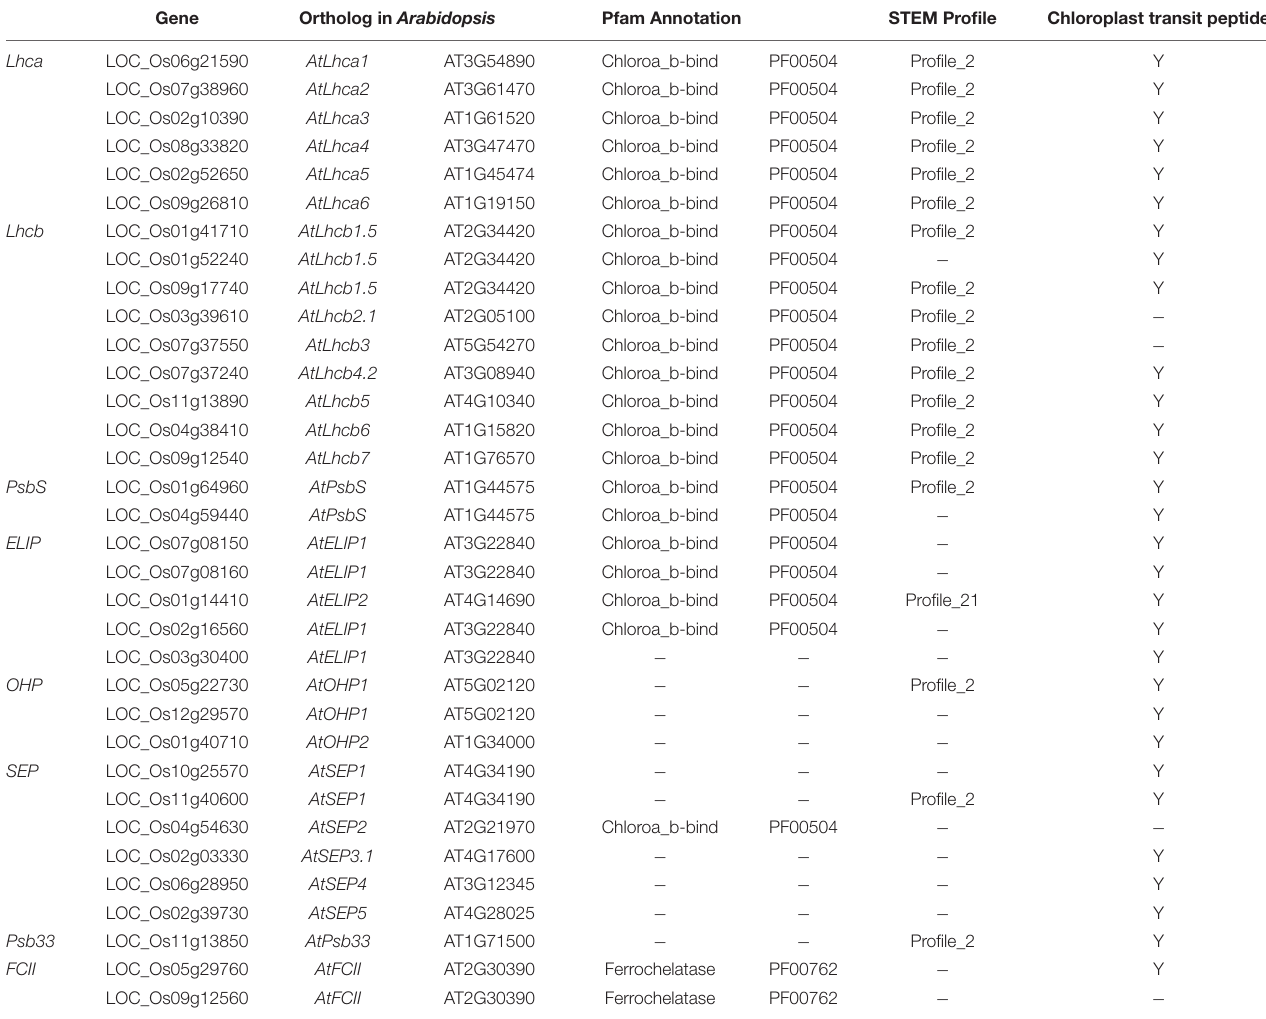
TABLE 3 | Detailed information of LHC superfamily genes in O. sativa . Gene Ortholog in Arabidopsis Pfam Annotation STEM Profile Chloroplast transit peptide